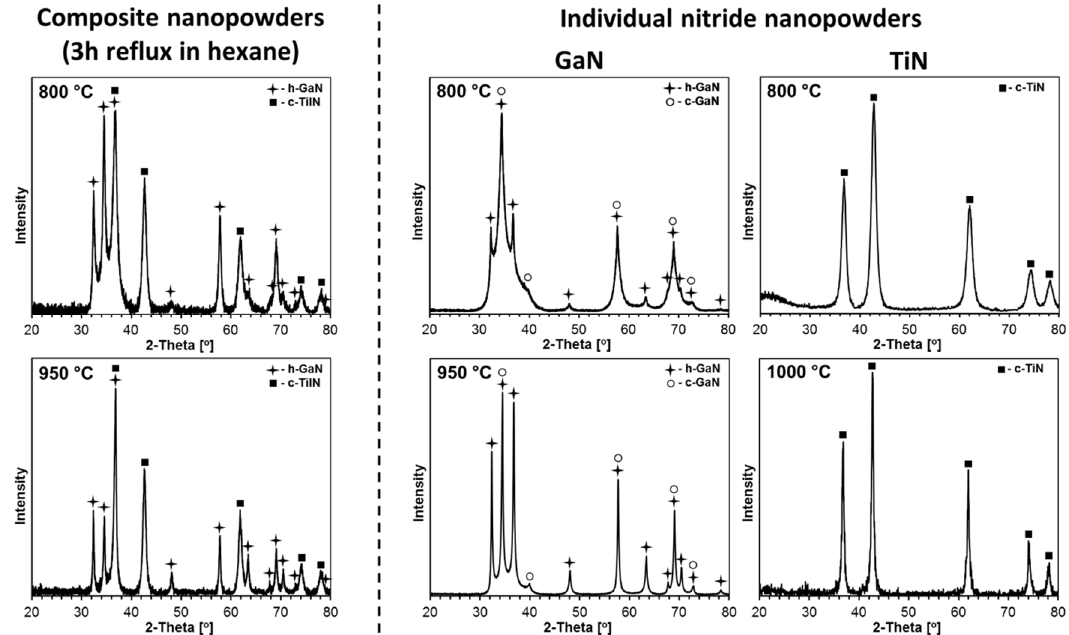
Figure 3. XRD patterns of composite ( left ) and individual ( right ) nitride nanopowders prepared at 800 and 950 °C in the system GaN–TiN. Note that the pattern for TiN nitrided at 1000 °C is shown instead of the common reference 950 °C. Table 1. XRD-derived lattice parameters and average crystallite sizes determined for composite and individual nitride